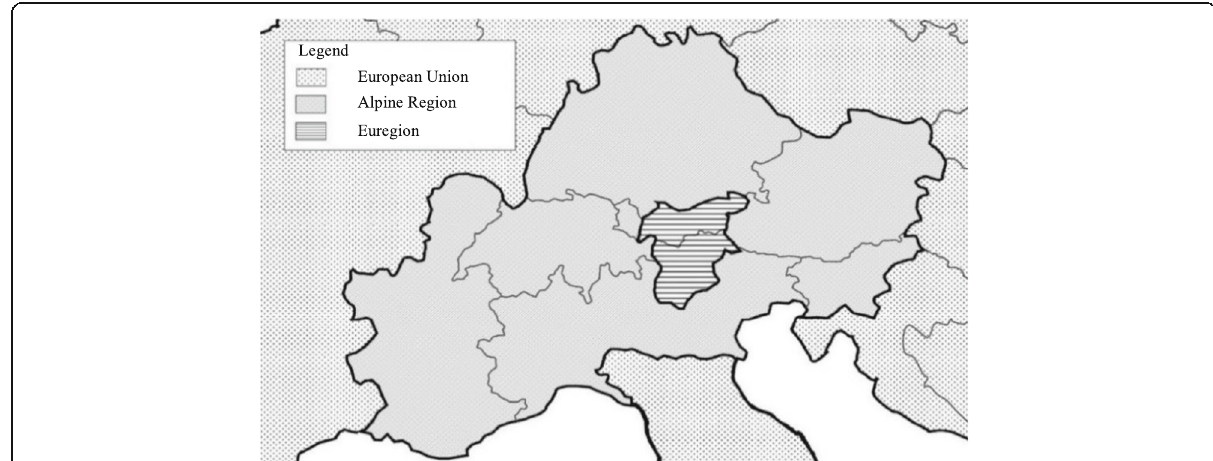
Fig. 2 The three geopolitical levels of the Brenner